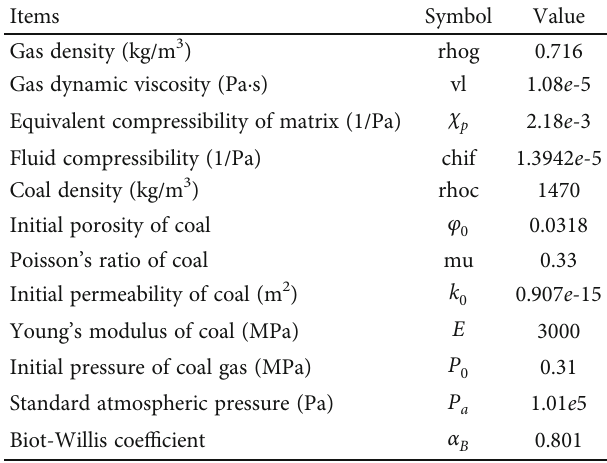
Table 1: Model parameter.